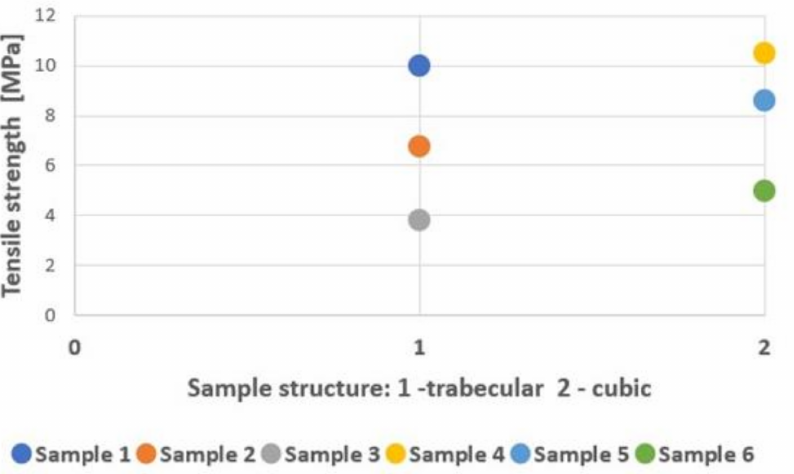
Figure 16. Comparison of the tensile strength of tested samples 1–6 considering the structure of the samples.